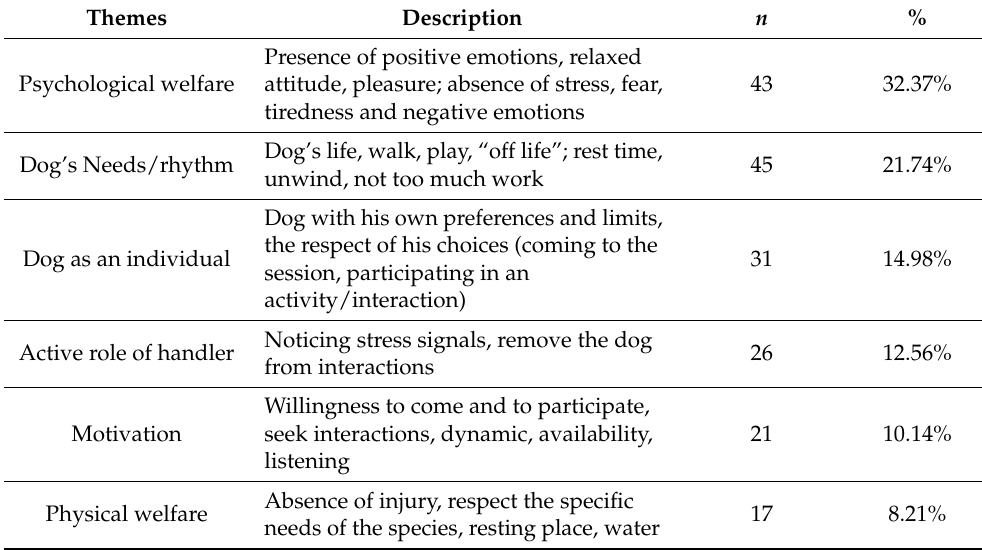
Table 2. This table represents the answers to the question “How would you define dog welfare in AAI?”. n = 101 complete answers. Total of 207 terms coded grouped into 7 themes; presented in descending